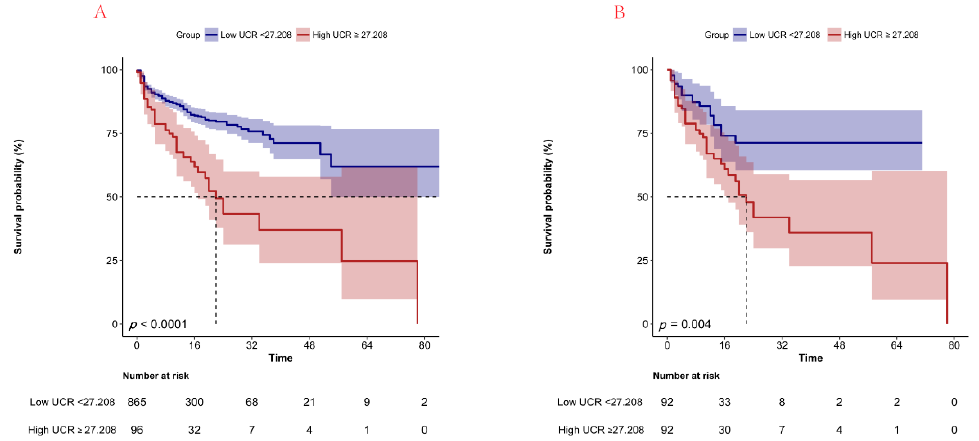
Figure 2. Kaplan–Meier survival curves of in-hospital mortality classified into two groups according to UCR before ( A ) and after PSM ( B ). UCR, urea nitrogen to creatinine ratio.